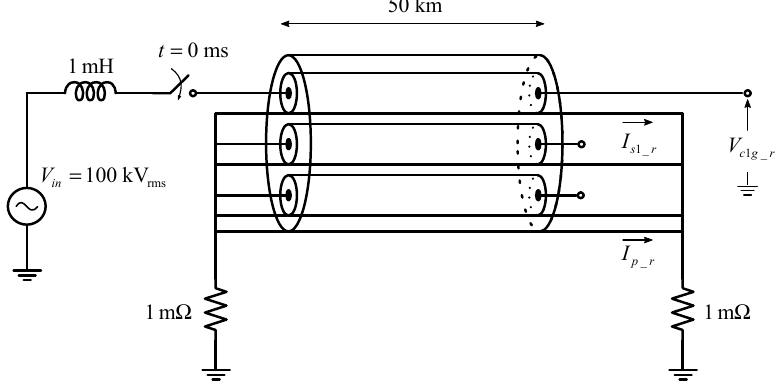
Figure 5. Setup for time response validation—Case Study #1.